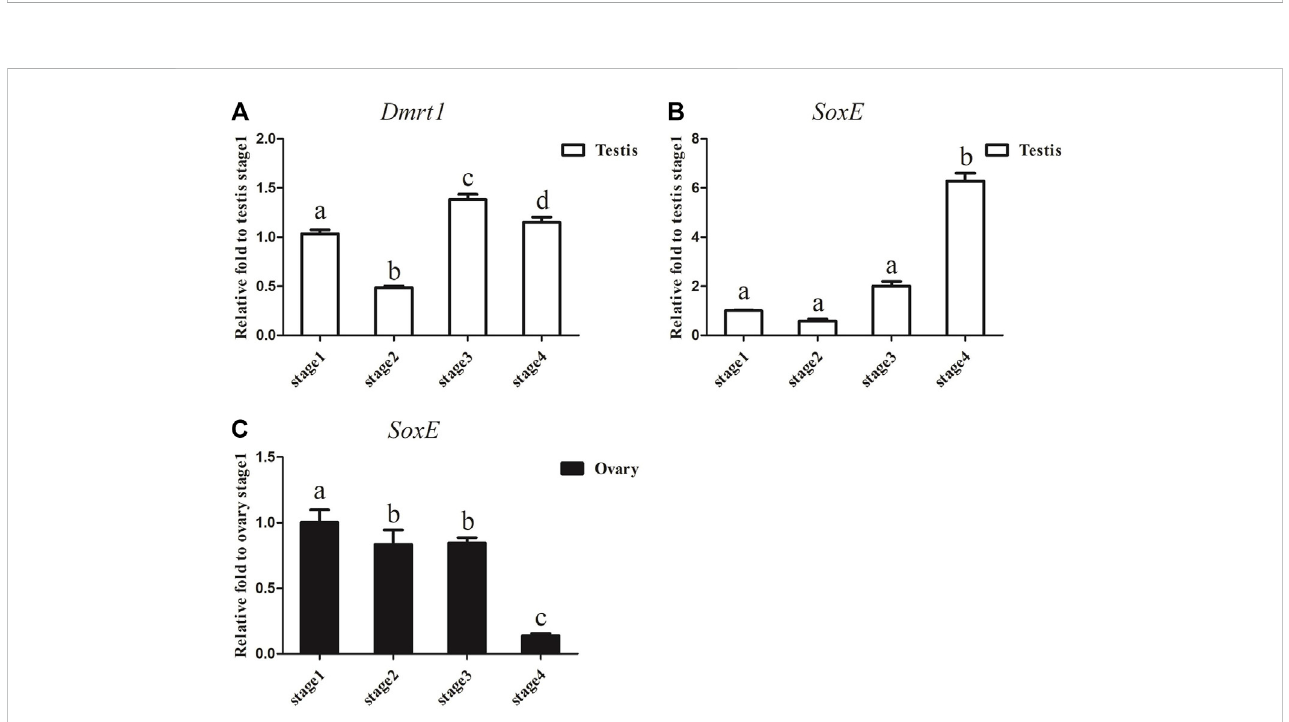
FIGURE 3 Dmrt1 and SoxE expression in gonad. (A) RT-qPCR analysis of Dmrt1 expression in testis at different development stages. (B) RT-qPCR analysis of SoxE expression in testis at different development stages. (C) RT-qPCR analysis of SoxE expression in ovary at different development stages. NADH was used as internal control. Data were performed from three independent experiments. Each bar represents mean ± SD. Different letters indicate signi fi cant differences between mean values ( p ≤ 0.05), whilst shared letters indicate no signi fi cant